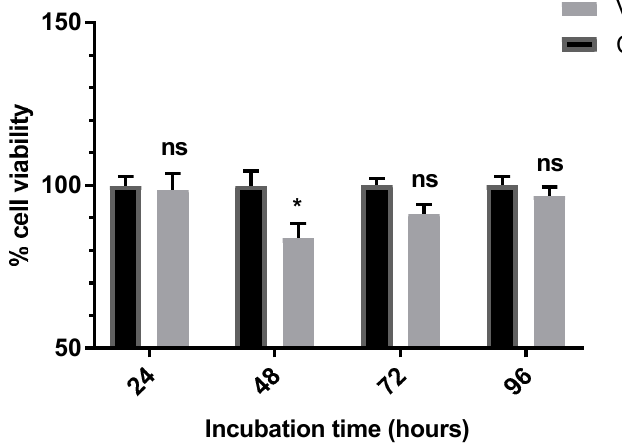
Figure 1. The percentages of cell viability of 1321N1 cells treated with 0.5% DMSO. Cells at the density of 1 × 10 5 cell/well were incubated with DMSO for up to 96 h. Cells were then subjected to MTT assay and the resulting absorbance values are expressed as a percentage of the values obtained with control, i.e., untreated-cells. The bars represent mean ± SEM ( n = 8 for 24 h, 16 for 48 h, 32 for 72 h and 24 for 96 h). * p = 0.0102; ns, not